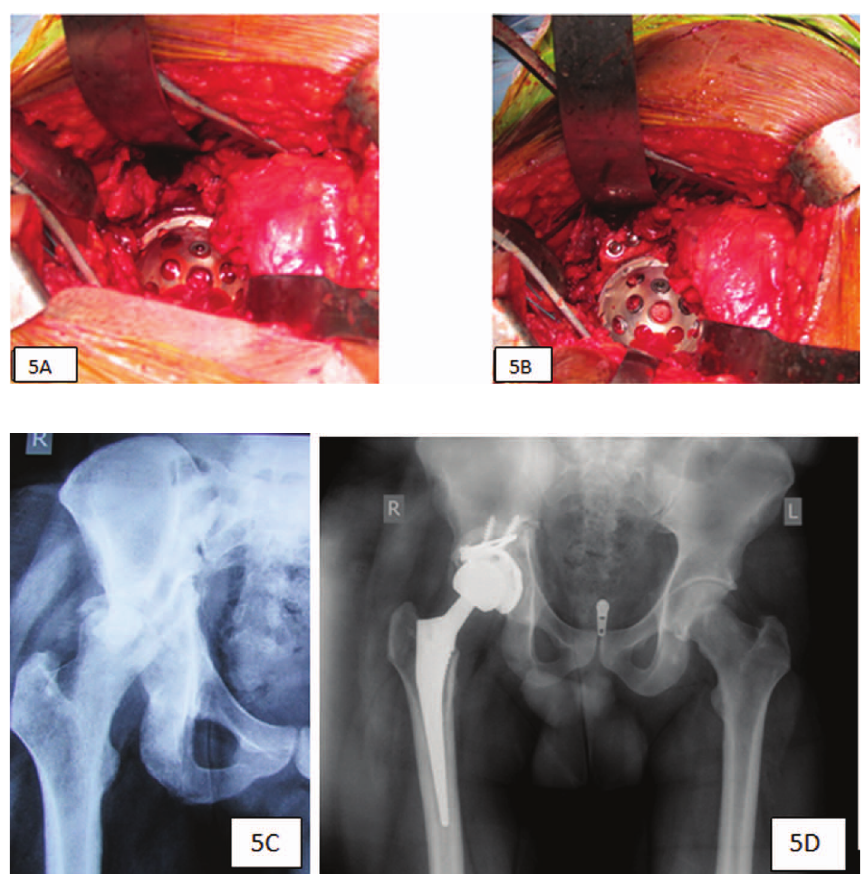
Figure 5. (A) Superior wall defect. (B) Superior defect reconstruction with a structural bone graft and screw fi xation. (C) Radiograph showing a superior wall fracture with femoral head subluxation. (D) Radiograph showing good bone graft incorporation at fi ve